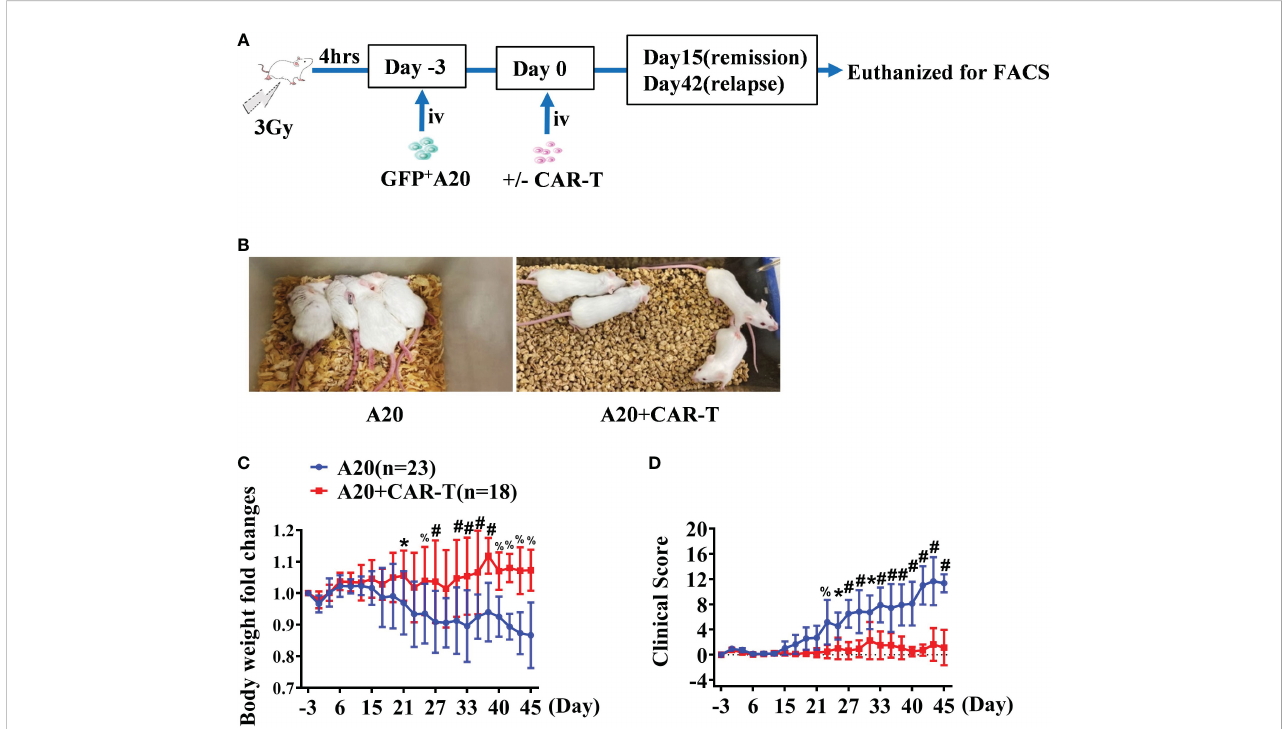
FIGURE 1 The general condition of anti-CD19 CAR T treated lymphoma mice. (A) The experiment design. (B) The state of the A20 induced lymphoma model. On day 32, the posture of mice injected with A20 cells combined with or without CD19 CAR-T cells were shown. (C) The body weight was tested every 2 – 3 days and the fold changes were analyzed. (D) Lymphoma models were evaluated, and the clinical score was recorded. Data were from two independent experiments. Two-way ANOVA was used to compare between the A20 (n = 23) and A20 + CAR-T groups (n = 18). * P < 0.01, % P < 0.001, # P <